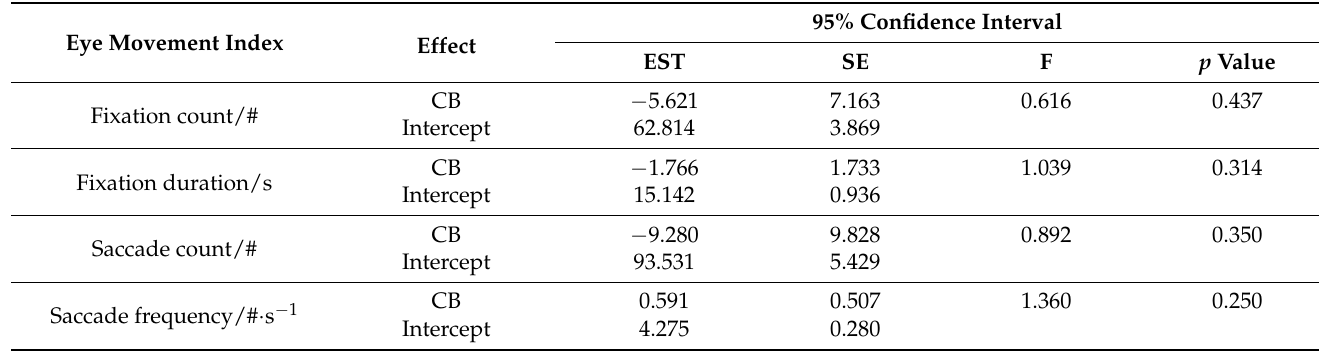
Table A1. Linear mixed model regression results of eye movement data in the mental rotation task (CB, cultural background; SE, standard error; EST,